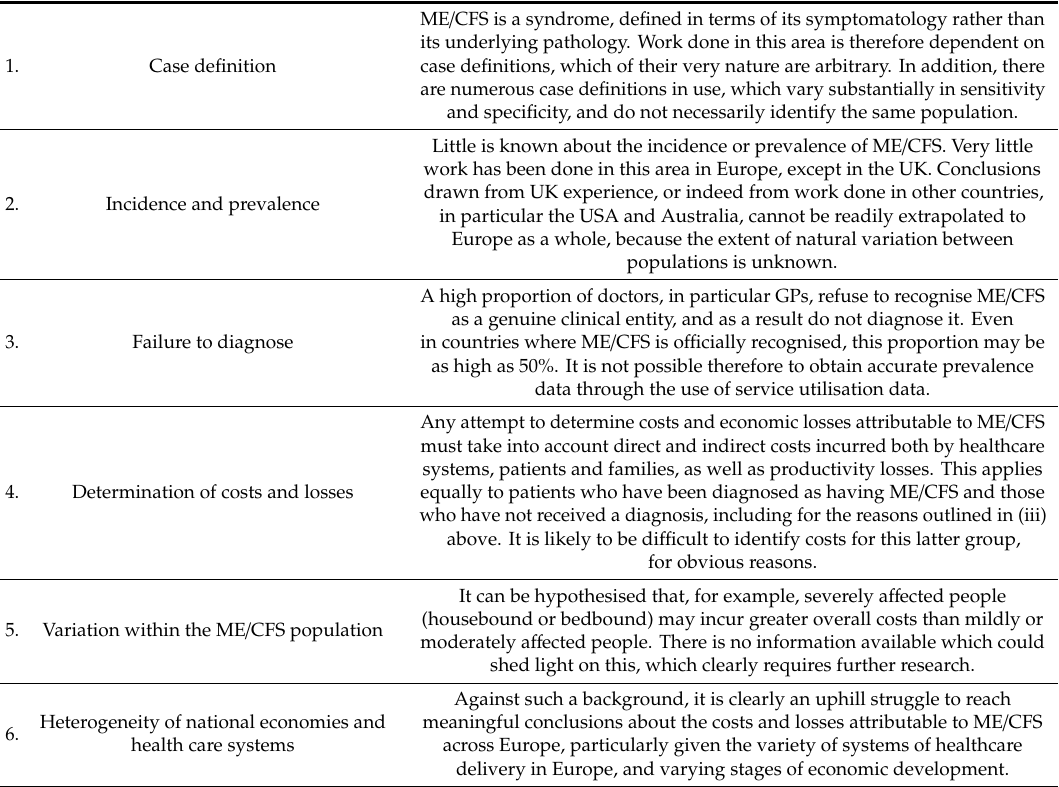
Table 1. Challenges in assessing the economic impact of ME / CFS in